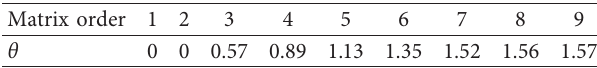
Table 2: Standard table of consistency index of reciprocal